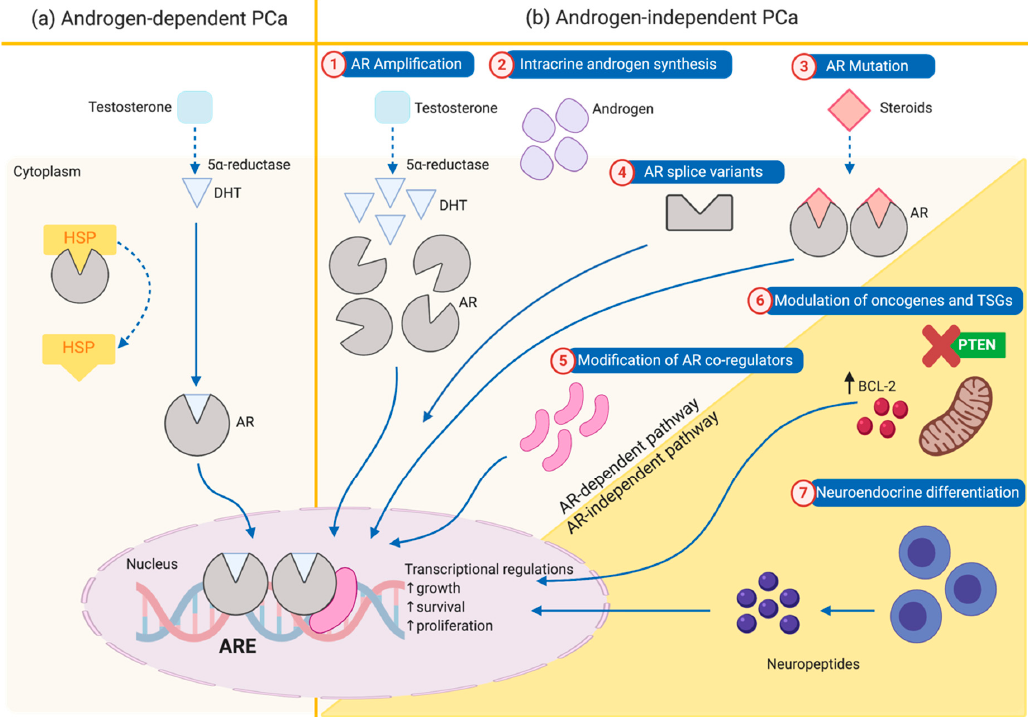
Figure 1. Molecular mechanisms of ( a ) androgen-dependent PCa (ADPC) and ( b ) development of androgen-independent prostate cancer (AIPC). The mechanism of the development of AIPC has been categorised based on AR-dependent that involving AR which include; ( 1 ) AR amplification, ( 2 ) intracrine androgen synthesis, ( 3 ) AR mutation, ( 4 ) AR splice variants and ( 5 ) modulation of AR co-regulators, ( 6 ) modulation of oncogenes and TSGs and ( 7 ) neuroendocrine differentiation. TSGs: Tumour suppressor genes; HSP: heat shock proteins; ARE: androgen response element; DHT: dihydrotestosterone; PTEN: phosphatase and tensin homologue deleted on chromosome-10.